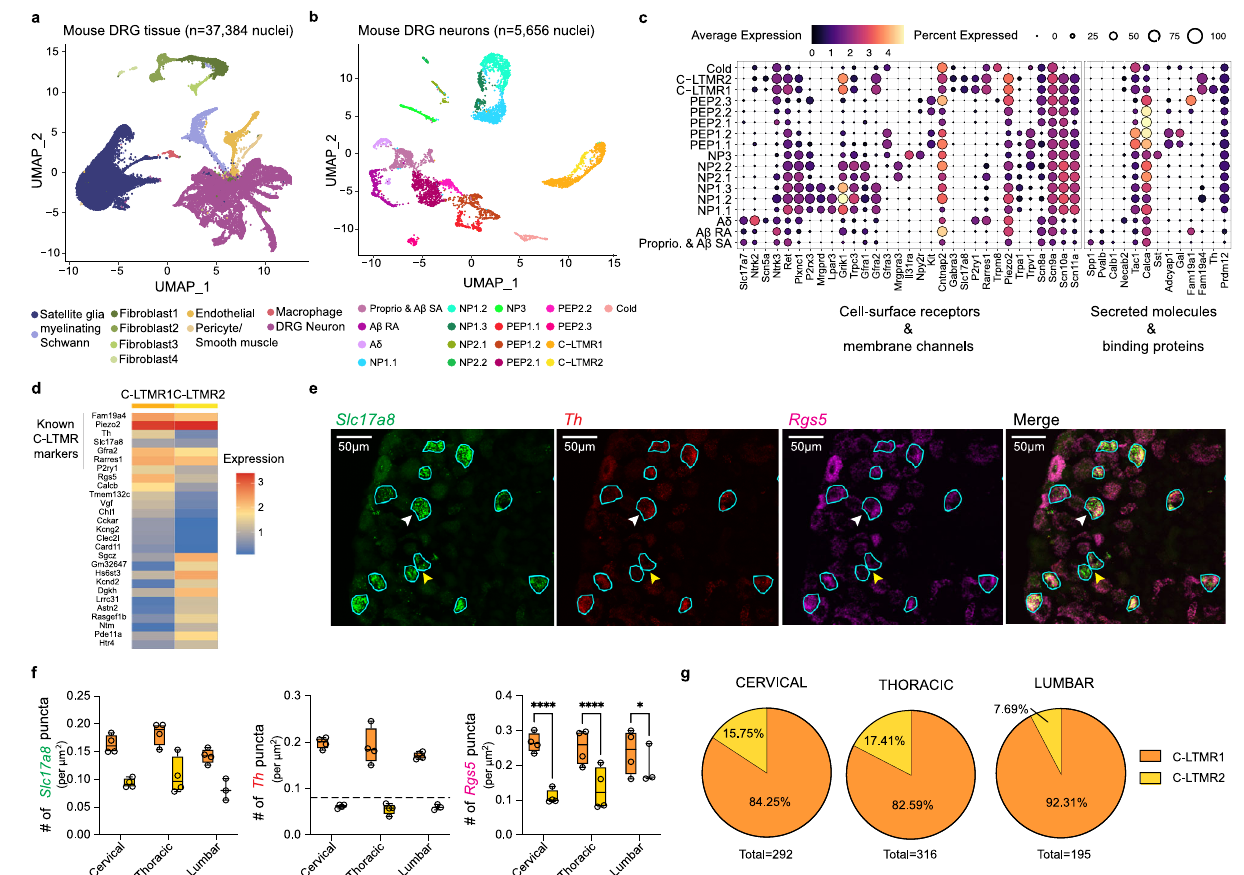
Fig. 2 | Single-nuclei transcriptome atlas of mouse dorsal root ganglia (DRG) sensory neurons. a UMAP of 37,384 mice DRG nuclei colored by cell types and annotatedbymarkergenesasindicatedinthemaintext. b UMAPof5656miceDRG neurons colored by subtypes and annotated by marker genes as indicated in the main text. NP denotes non-peptidergic; PEP denotes peptidergic for a and b . c Fraction of nuclei (dot size) in each subset expressing canonical marker genes (columns) and their scaled average expression level in expressing cells (dot color) within subtypes (rows). d Heatmap comparing mean expression levels(color bars) of top differentially expressed genes (rows) between C-LTMR1 and C-LTMR2 sub- types. e Representative images for RNAScope validation of Rgs5, Th , and Slc17a8 expression in mouse DRGs. Neurons are outlined in turquoise. White arrowheads indicate Slc17a8 -positivecellsexpressingbothhighlevelsof Th and Rgs5 andyellow arrowheadsindicatecellsthatexpress Slc17a8 -positivecellsbutlowamountsof Th